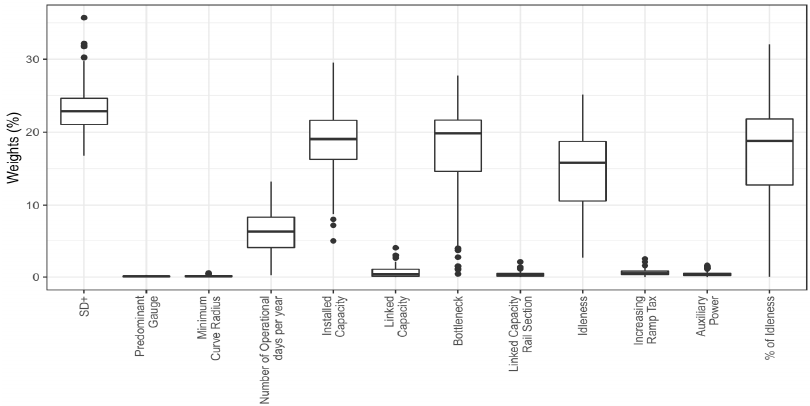
Figure 7. Relative importance of models (1)–(12).